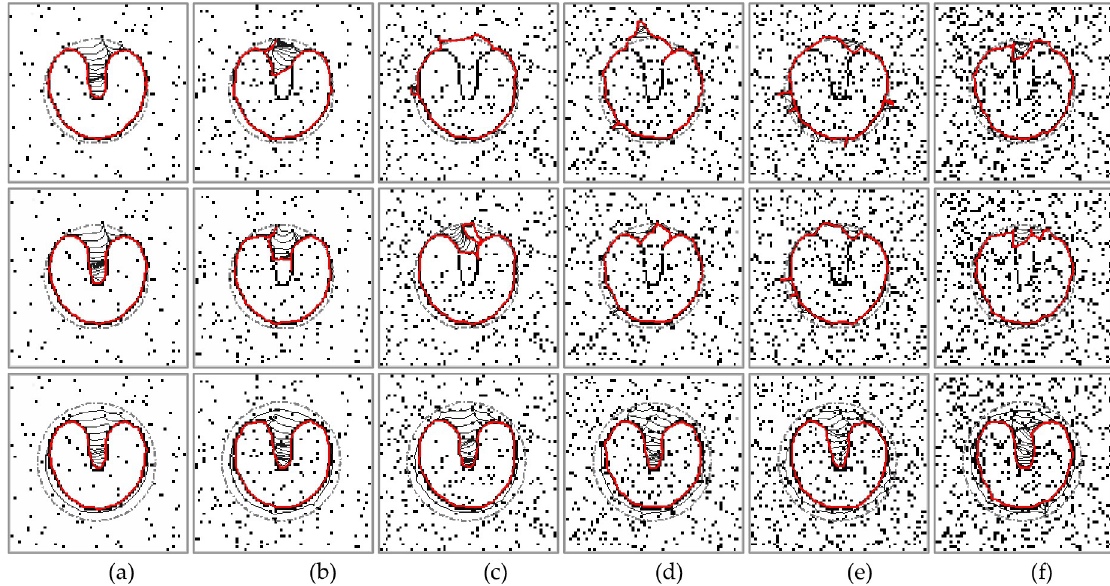
Fig 3. Noise resistance. U-shape images corrupted with varying salt-and-pepper noises that are (a) 0.05, (b) 0.10, (c) 0.15, (d) 0.2, (e) 0.25, (f) 0.3. First row: results of the GVF snake with μ = 0.2. Second row: results of the VEF snake. Third row: results of the MCONVEF snake with h = 1.2, k = 100, L = 2. To note when the value of the parameter k is 100, g role in noise resistance.